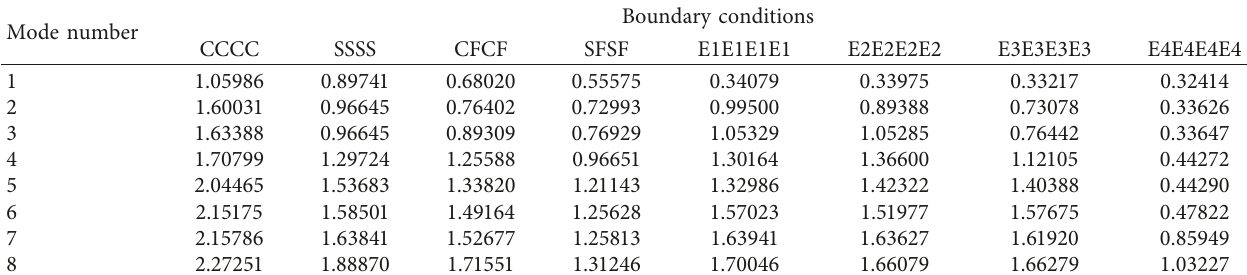
Table 9: First eight frequency parameters Ω of an orthotropic plate with different boundary conditions ( h / a � 0.6).